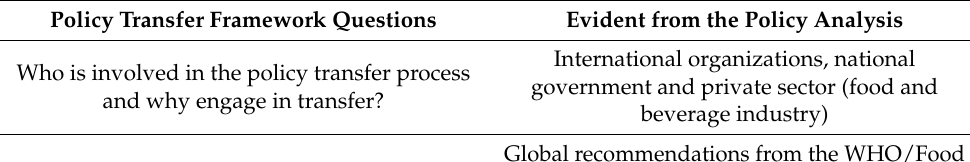
Table 1. Policy transfer framework and structure of the policy analysis